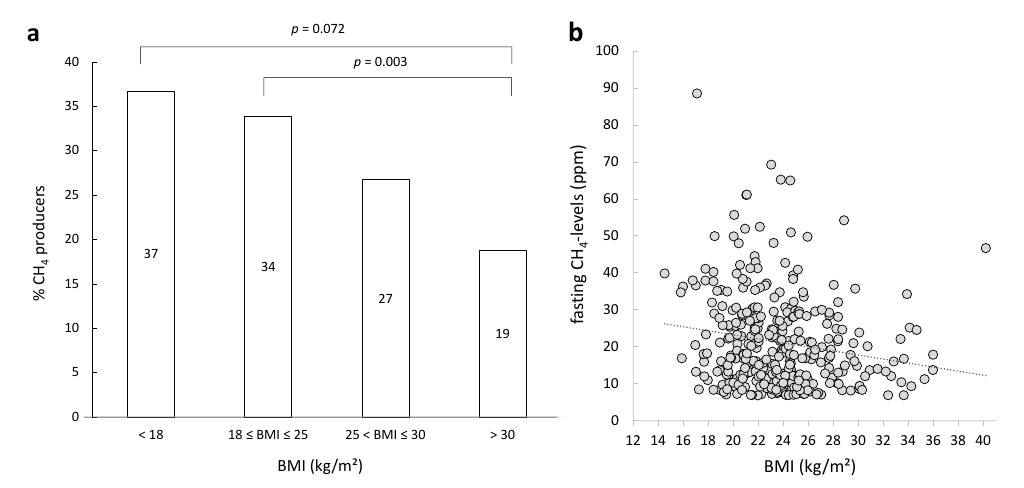
Figure 1. Percentage of CH 4 producers in fasting state as function of body mass index (BMI) ( a ) and correlation between fasting CH 4 and BMI ( b ).